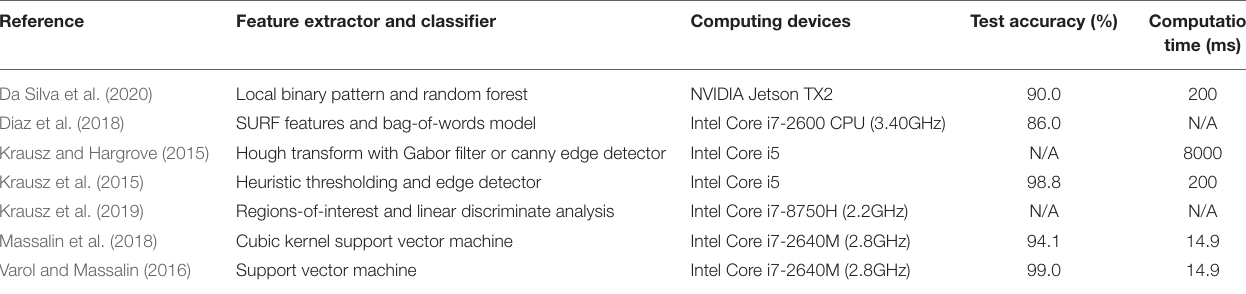
TABLE 2 | Previous environment recognition systems that used heuristics, statistical pattern recognition, or support vector machines for image classification of walking